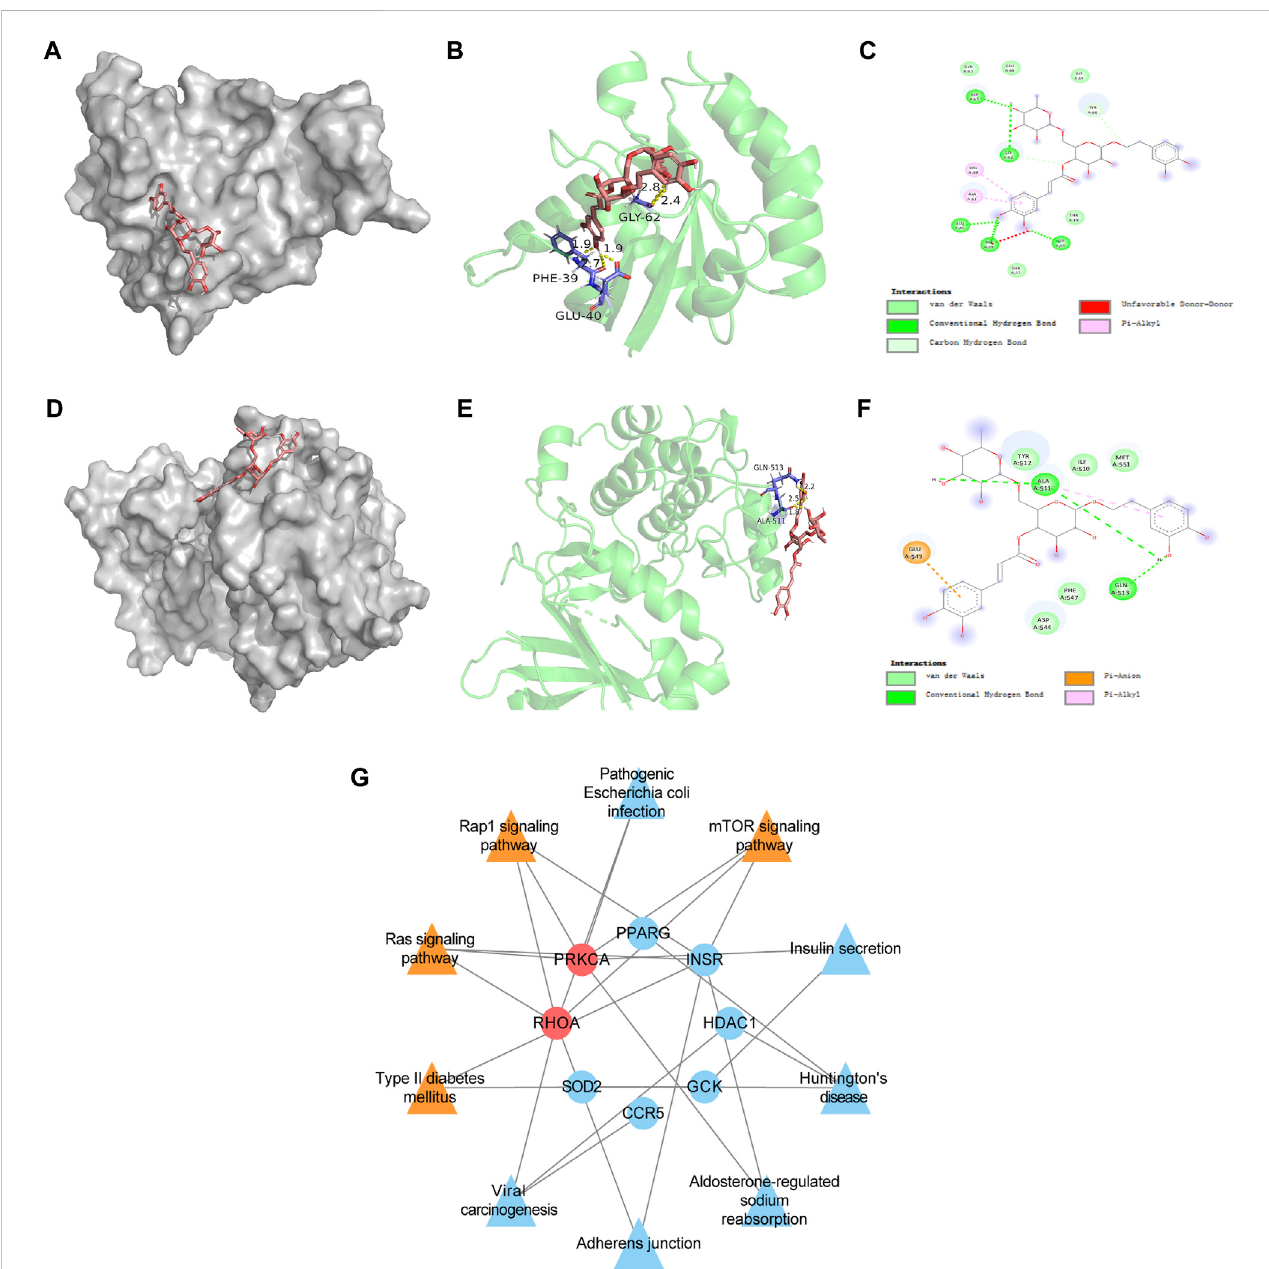
FIGURE 7 Molecular docking data of RHOA target and PRKCA target and compound-target-pathway network of Forsythiaside and diabetic podocytopathy. (A) Schematics (3D) showed that molecular model of Forsythiaside fi tting in the binding pocket of the RHOA protein. (B) Schematics (3D) represented the interactions between Forsythiaside and surrounding residues of RHOA. The yellow dashed lines showed hydrogen bonds and the interaction distances were indicated. (C) Schematics (2D) revealed the interaction forces between Forsythiaside and RHOA. (D) Schematics (3D) represented that molecular model of Forsythiaside fi tting in the binding pocket of the PRKCA protein. (E) Schematics (3D) showed the interactions between Forsythiaside and surrounding residues of PRKCA. The yellow dashed lines showed hydrogen bonds and the interaction distances were indicated. (F) Schematics (2D) revealed the interaction forces between Forsythiaside and PRKCA. (G) The compound-target-pathway network was established to explore the potential mechanisms of Forsythiaside treating diabetic